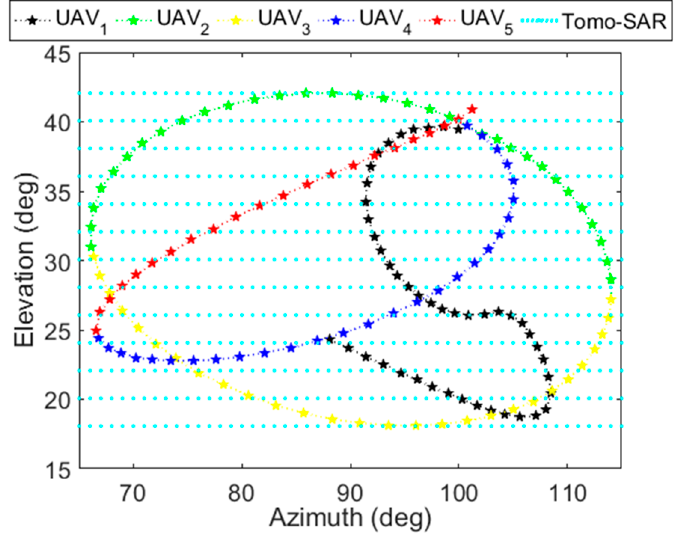
Figure 1. The flight trajectory of Tomo-SAR and five UAVs with SAR system in cooperative flight.